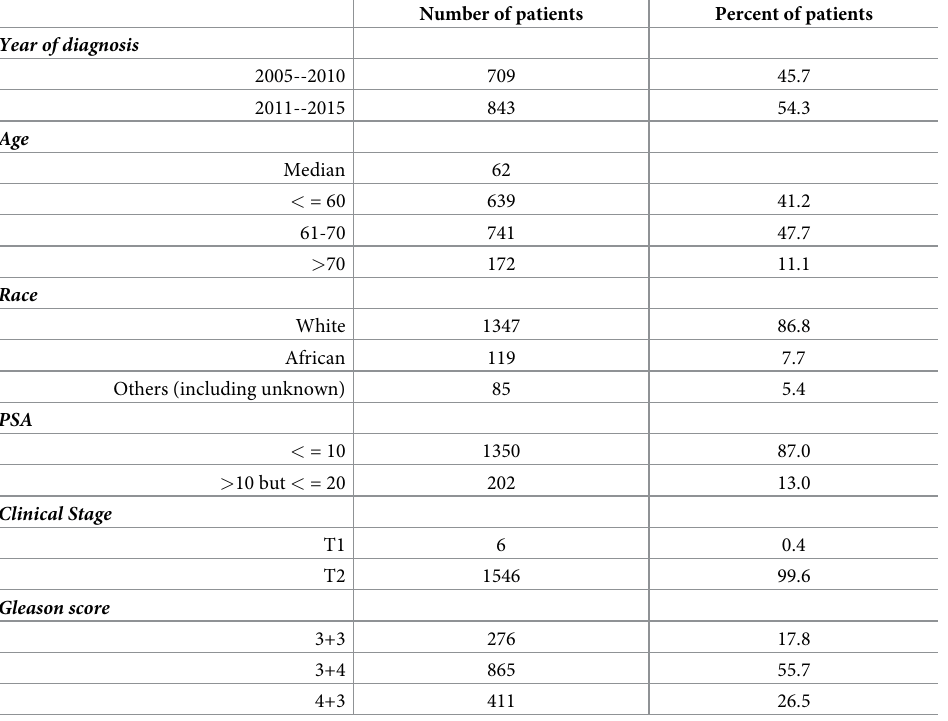
Table 1. Baseline patient